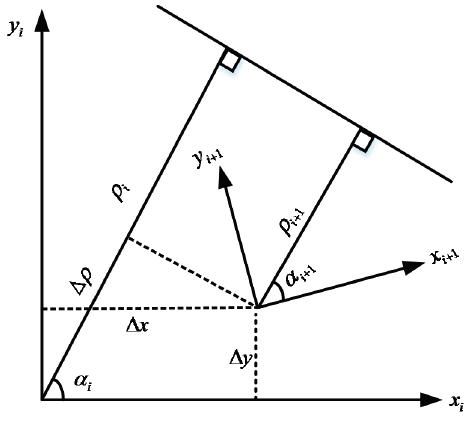
Figure 1. The vehicle pose change over two consecutive